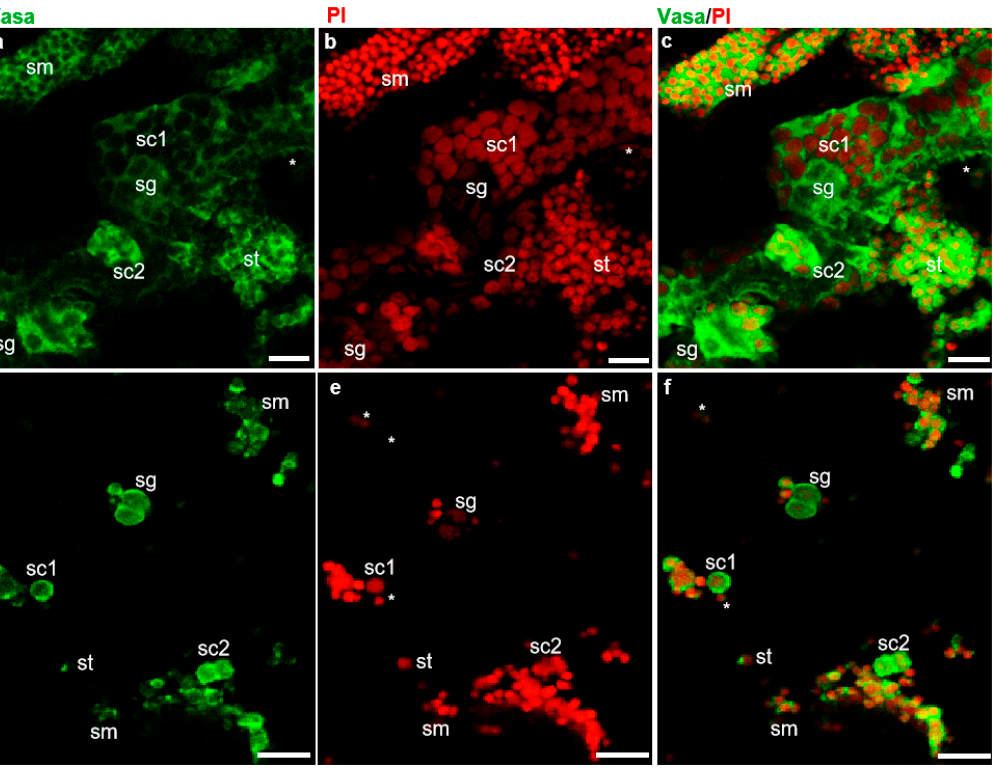
Figure 2. Identification of testicular cells by fluorescent immunostaining. Fluorescent immunostaining on testis sections and isolated testicular cells of adult American shad (2Y + ). ( a – c ), sections. ( d – f ), Testicular cells. Green fluorescence is for Vasa protein ( a , c ) and red fluorescence is the nuclear staining with propidium iodide (PI) ( b , e ); ( c ) and ( f ) are the merged images. sg, spermatogonia. sc, spermatocytes. st, spermatids. sm, spermatozoa and somatic cells indicated with asterisks. Scale bars, 20 µm.